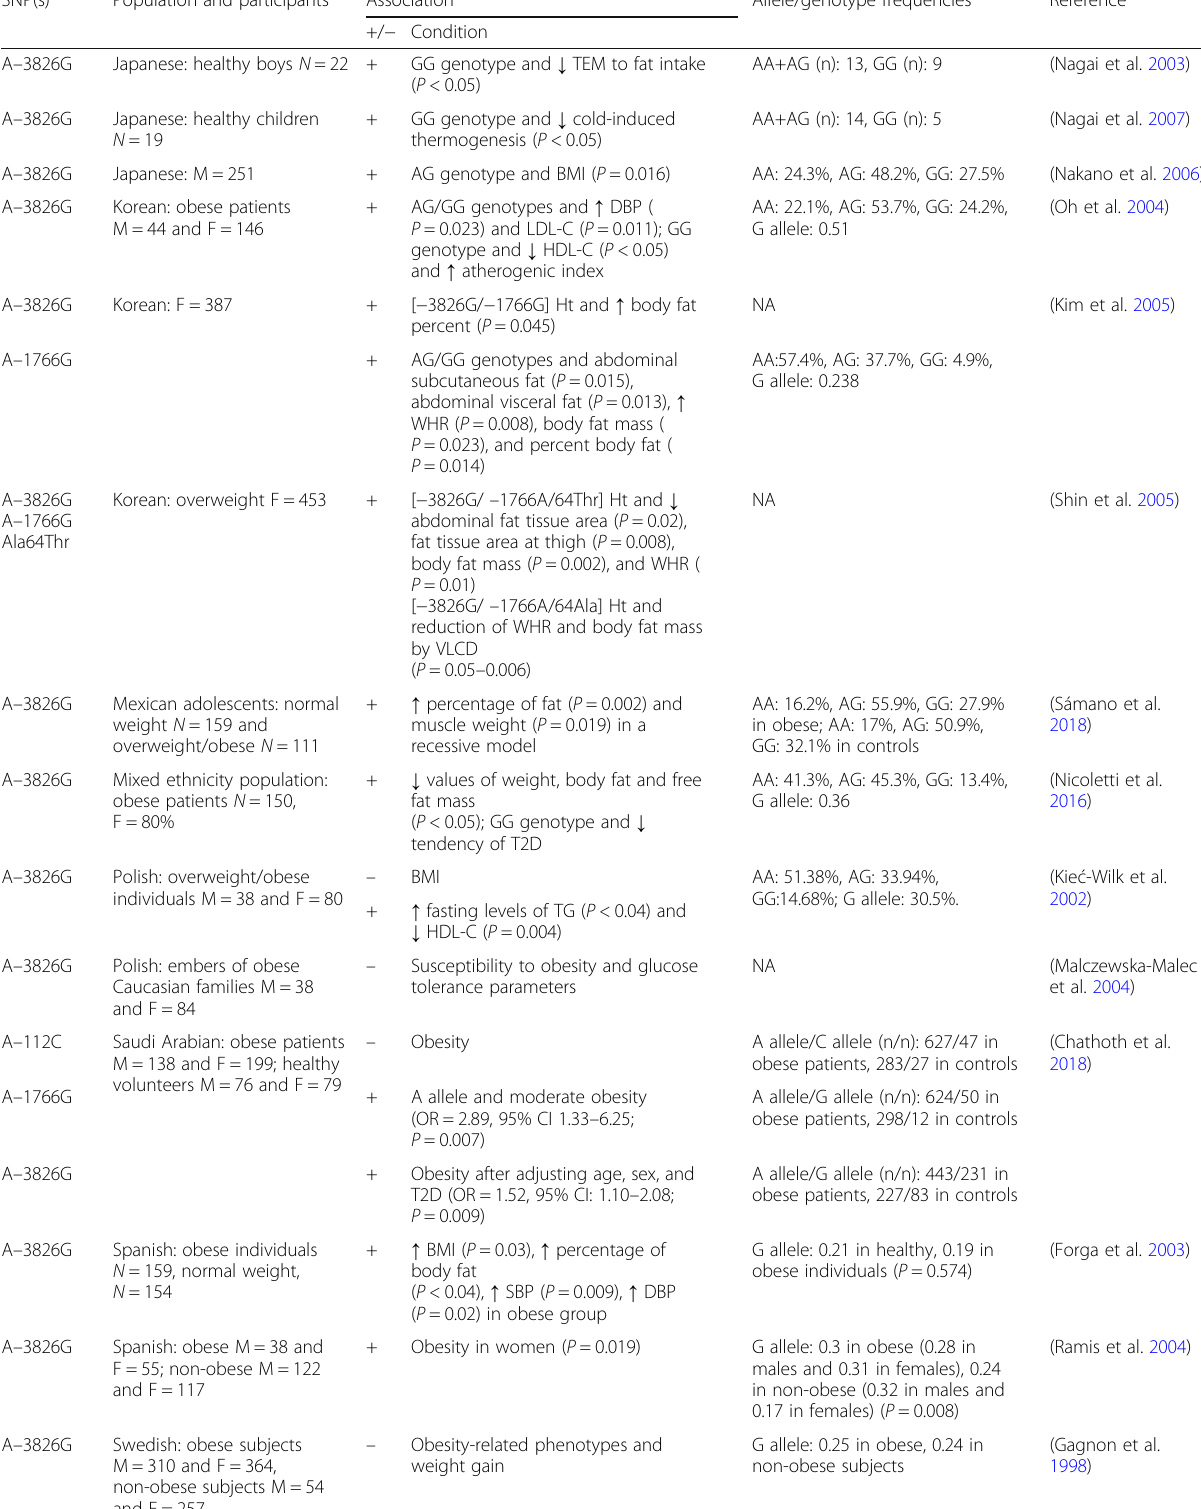
Table 1 Studies on the association between the Ucp1 polymorphisms and CMDs or CMD risk factors in different populations